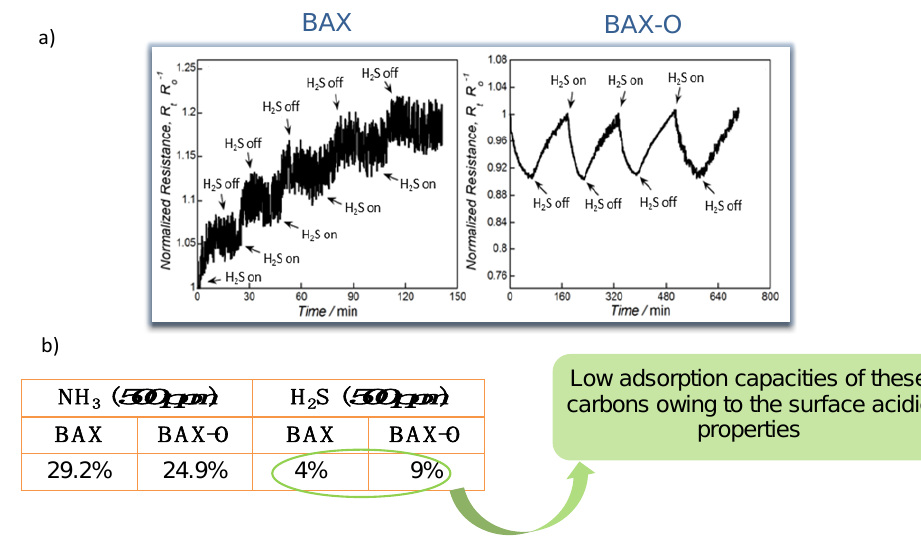
Figure 3. ( a ) Response of sensors to H 2 S and ( b ) normalized resistance changes upon exposure to 500 ppm of NH 3 and H 2 S (in %). Adapted with permission from Reference [20]. Copyright 2015. The Royal Society of Chemistry.